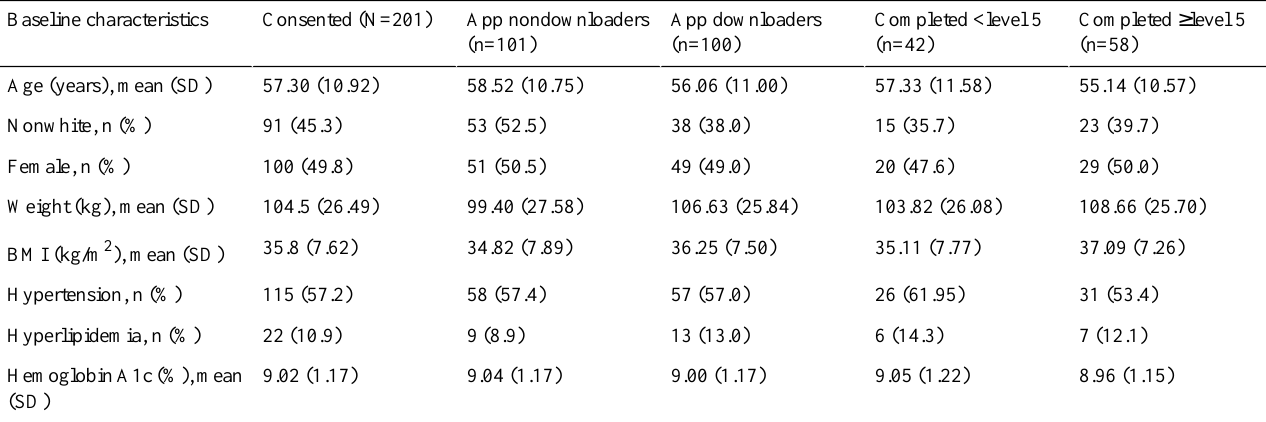
Table 2. Baseline characteristics across levels of